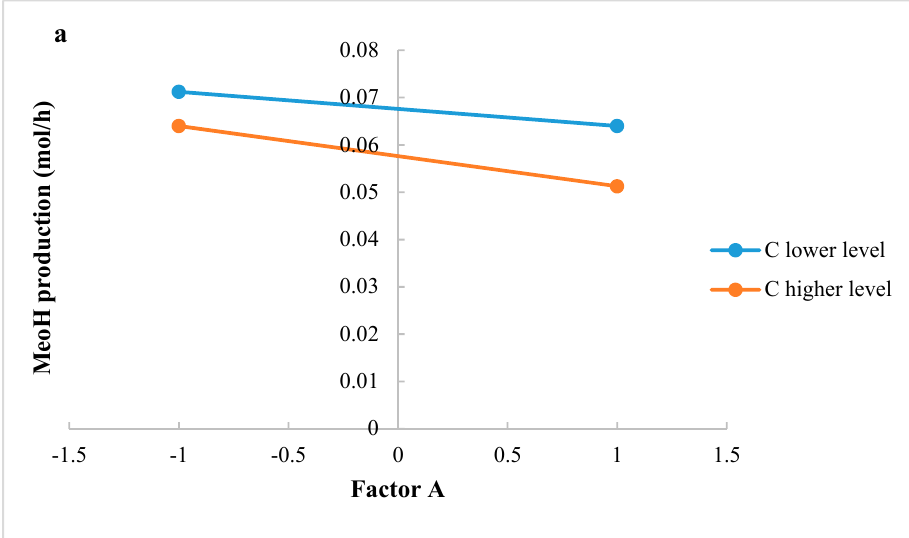
Figure 6. Cont . Figure 6.